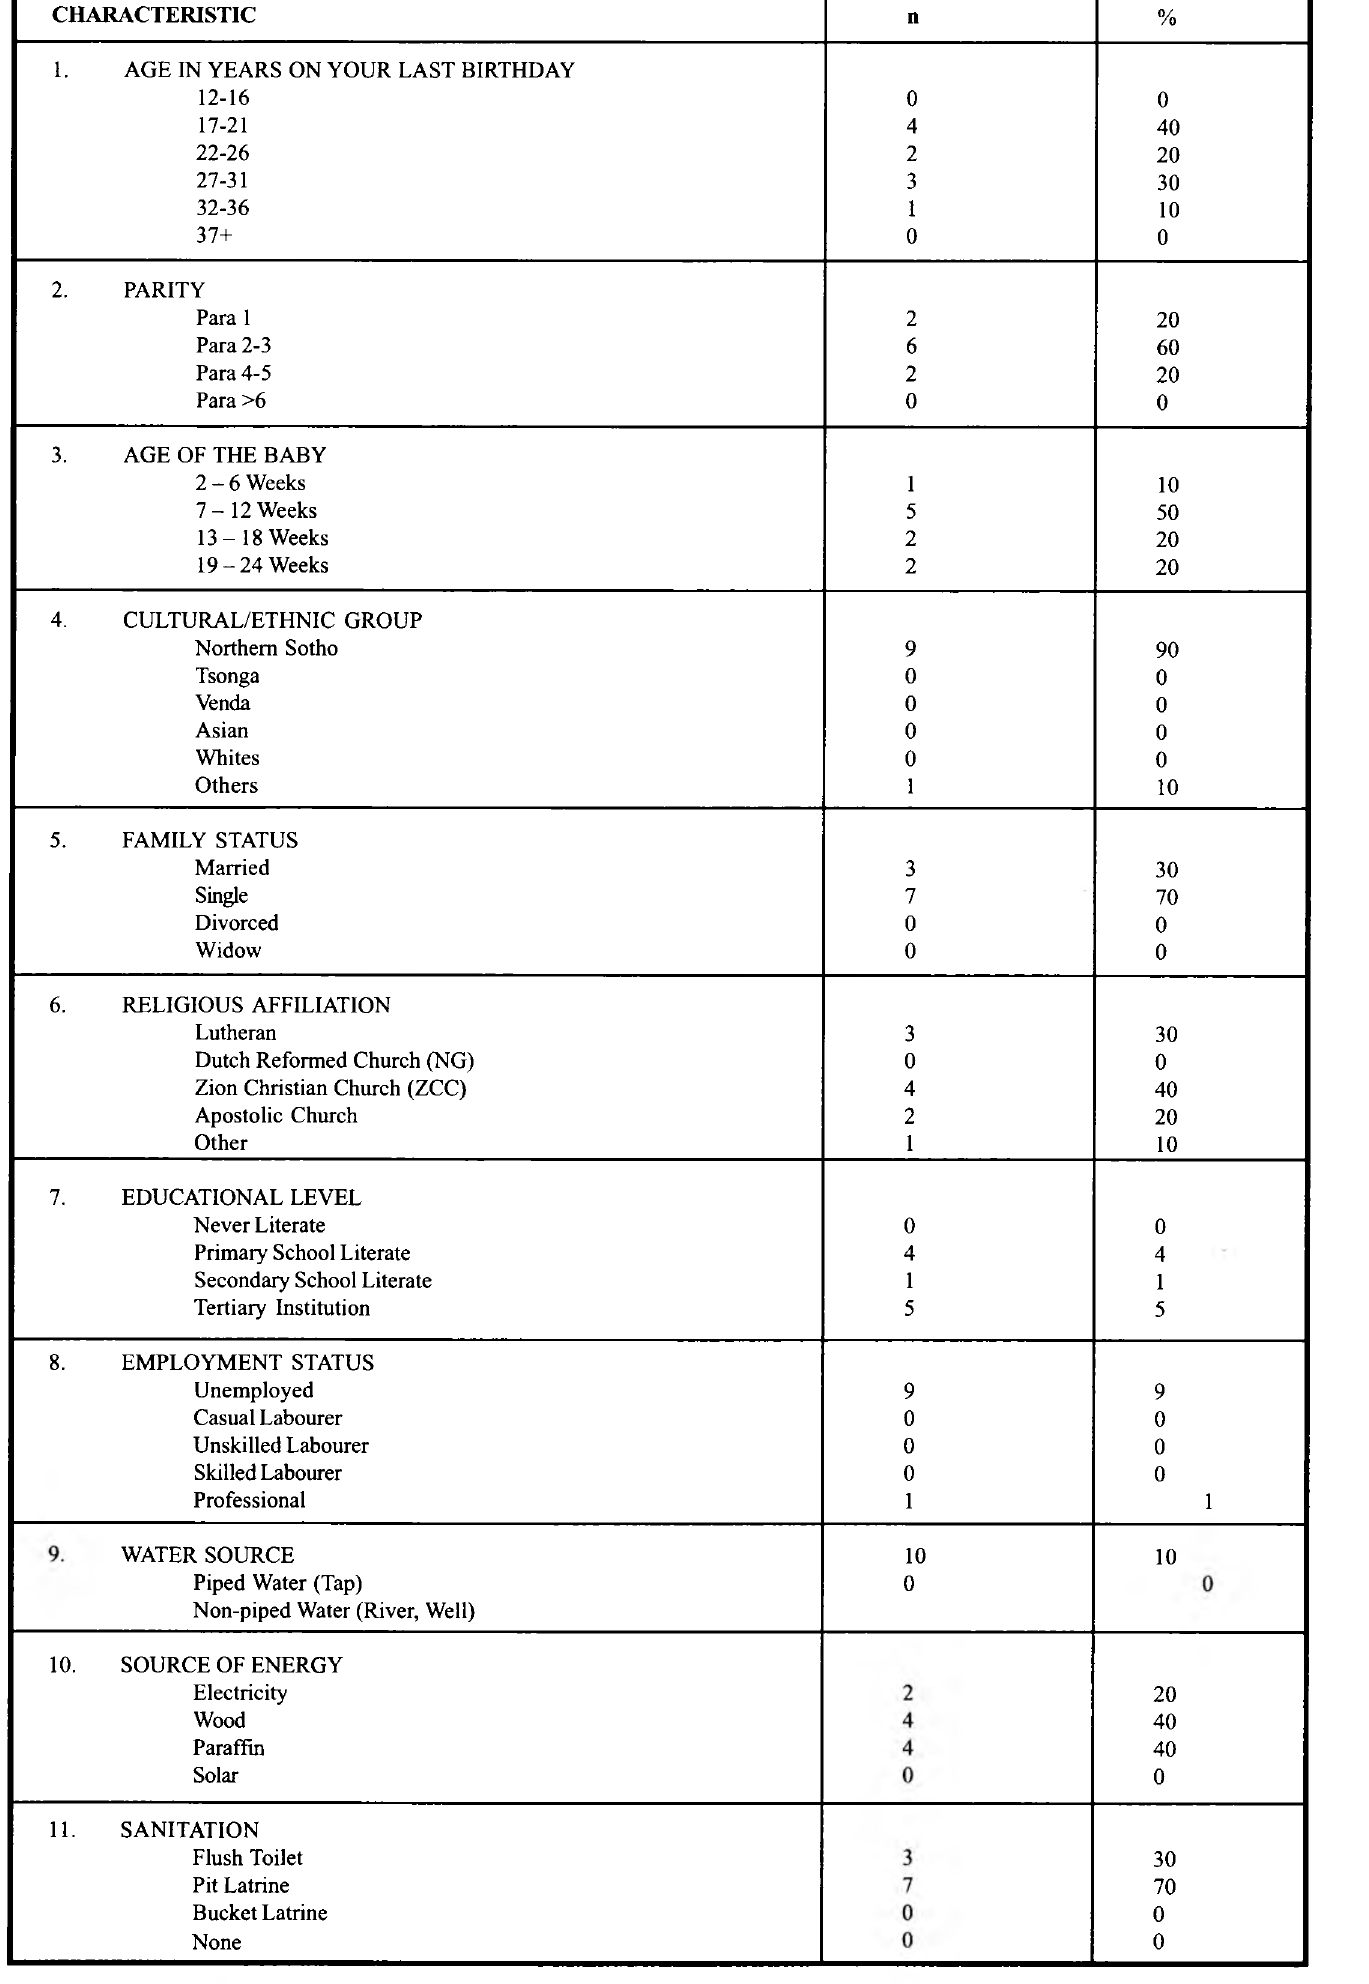
Table 1: Profile of HIV-positive Mothers Recruited to the Study (n =10) CHARACTERISTIC n %